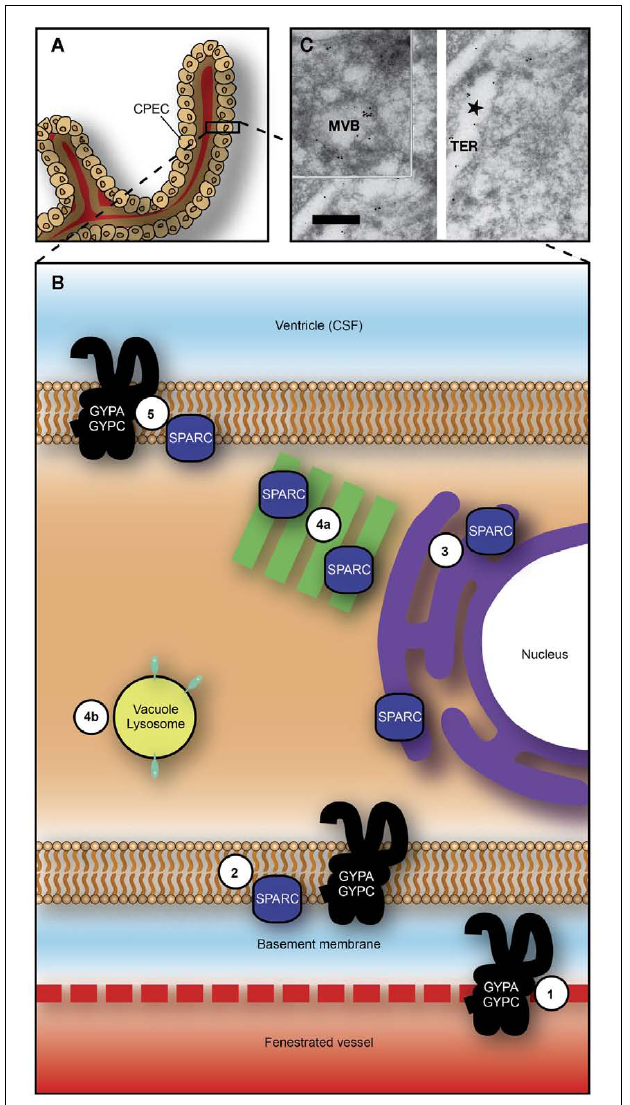
FIGURE 4 | Proposed transepithelial pathway for albumin through choroid plexus epithelial cells. (A) Whole choroid plexus showing single layer of epithelial cells sitting on thick basement membrane (see also Figure 1C ). (B) Suggested routes of albumin from plasma into CSF across the choroid plexus epithelium. GYPA/C in endothelial cells may deliver albumin to basement membrane (1) from where it can be taken up into plexus epithelium by GYPA/C or SPARC (2). Albumin may then travel along a SPARC-specific pathway through tubulocisternal endoplasmic reticulum [3, and see (C) ] and Golgi (4a), or via aVAMP-mediated pathway in vacuoles, lysosomes, or multivesicular bodies [4b, and see (C) ]. On apical surface of plexus epithelium, GYPA/C may be involved in efflux of protein from the cell into CSF (5). In adult, lack of immunoreactivity in endoplasmic reticulum and Golgi and increased expression of gene products forVAMP molecules, suggest that majority of transport occurs viaVAMP-mediated vesicular transport (4b). (C) Transmission electron micrograph of ultracryosection from E60 fetal sheep choroid plexus (Balslev et al., 1997b). Immunolabeled human albumin 6nm particles and sheep albumin 12nm gold particles are shown to co-localize within the tubulocisternal endoplasmic reticulum. Abbreviations: CPEC, choroid plexus epithelial cell; CSF, cerebrospinal fluid; GYPA, glycophorin A; GYPC, glycophorin C; MVB, multivesicular body;TER, tubulocisternal endoplasmic reticulum. Scale bar: 0.2 μ m in (C) . Image from Liddelow et al.